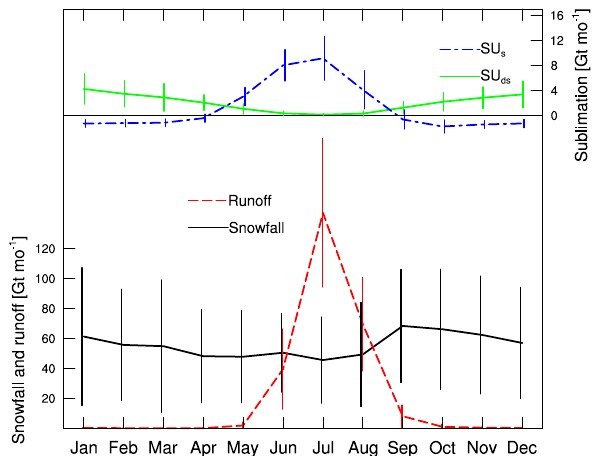
Fig. 7. Mean (1960–2011) annual cycle (January–December) of snowfall (left axis) and SU ds , SU s and runoff (right axis), all in Gt yr − 1 and their temporal standard deviation (square root of in- terannual variability; vertical bars denote 2 σ ). The horizontal black line represents 0Gt yr − 1 on the right axis.